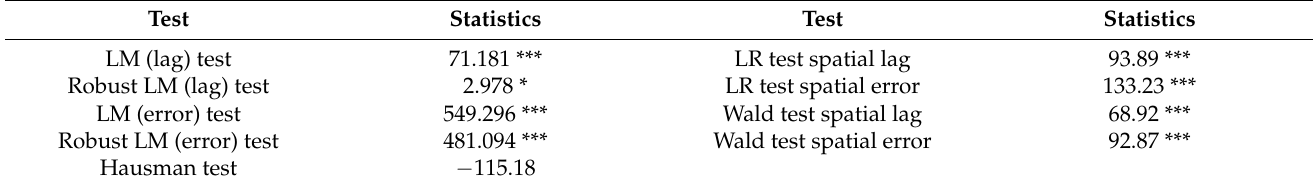
Table 2. Test results of spatial